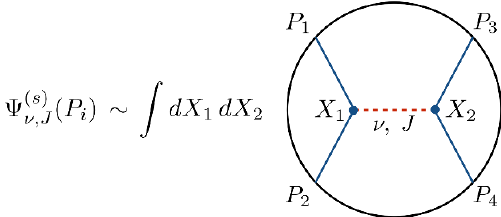
Figure 2 . (cid:9) (s) ( P i ) can be expressed as a bulk exchange diagram. Here the blue lines are bulk-to- (cid:23);J boundary propagators and the internal dashed line denotes the AdS harmonic